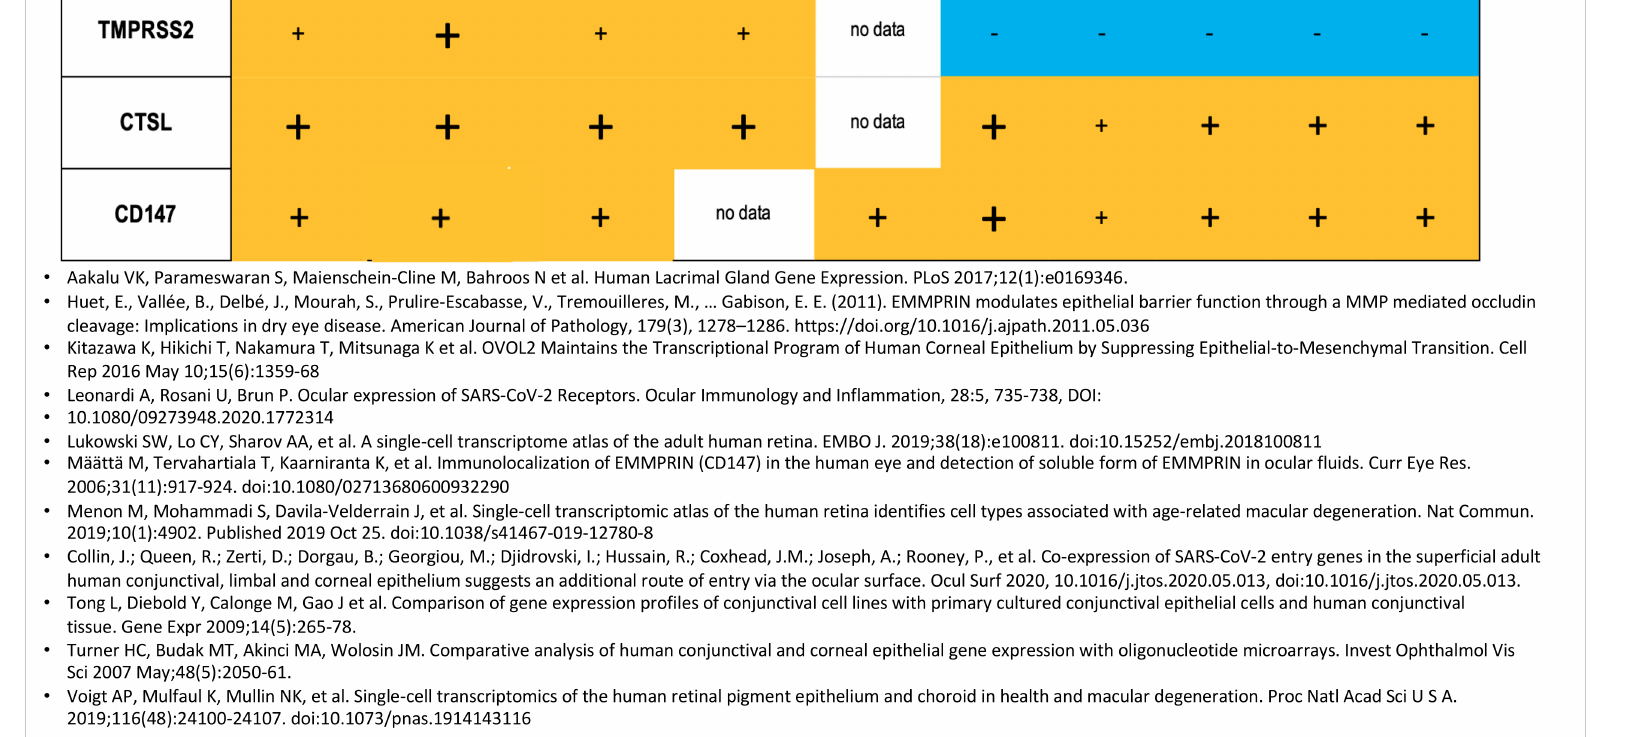
Figure 4. Relative expression of TMPRSS2, CD147, ACE-2 and CTSL in ocular structures. The figure summarizes data available from immunohistochemistry and gene expression profiles. (-) No expression, ( + ) Low expression, ( + ) Moderate expression, ( + ) High